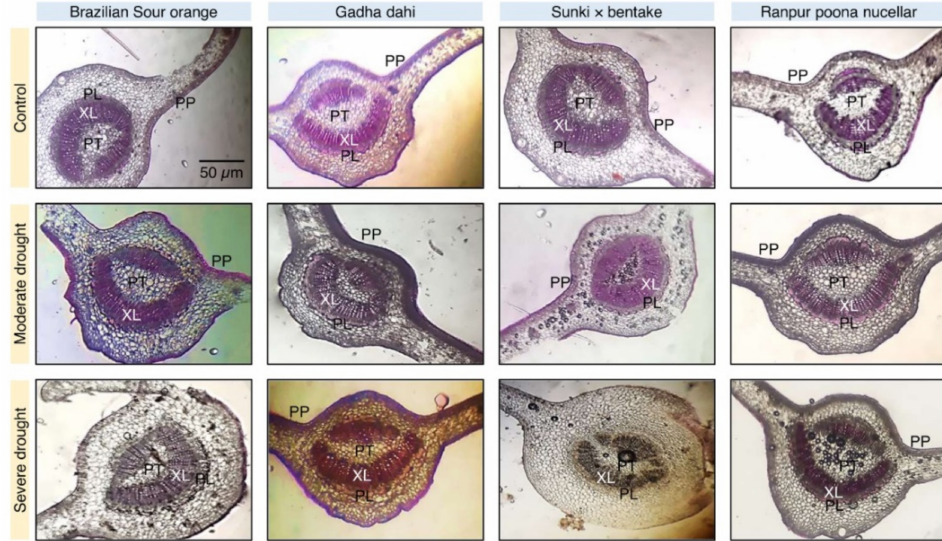
Figure 6. Leaf transverse section of two highly tolerant (Brazilian sour orange and Gadha dahi) and two highly sensitive genotypes (Rangpur Poona nucellar and Sunki × bentake). PT: pith; CR: cortex; XL: xylem; PL: phloem; PP: palisade